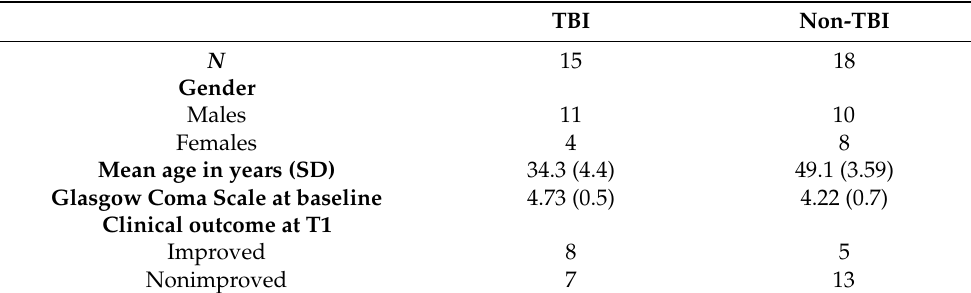
Table 1. Demographic and clinical